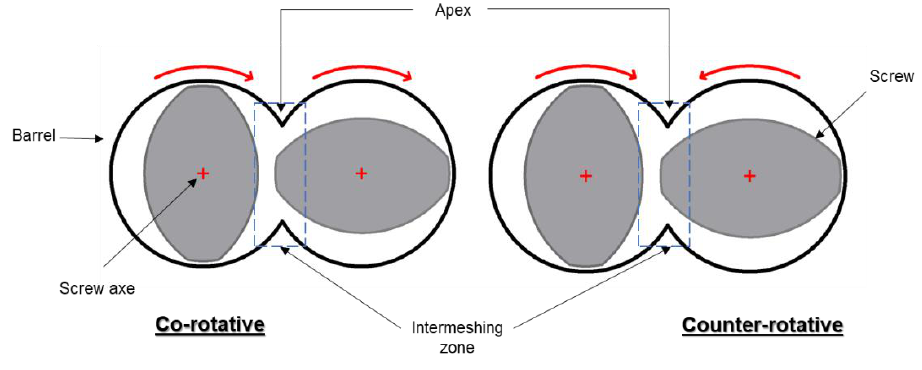
Figure 6. Co- and counter-rotative extruder screws.